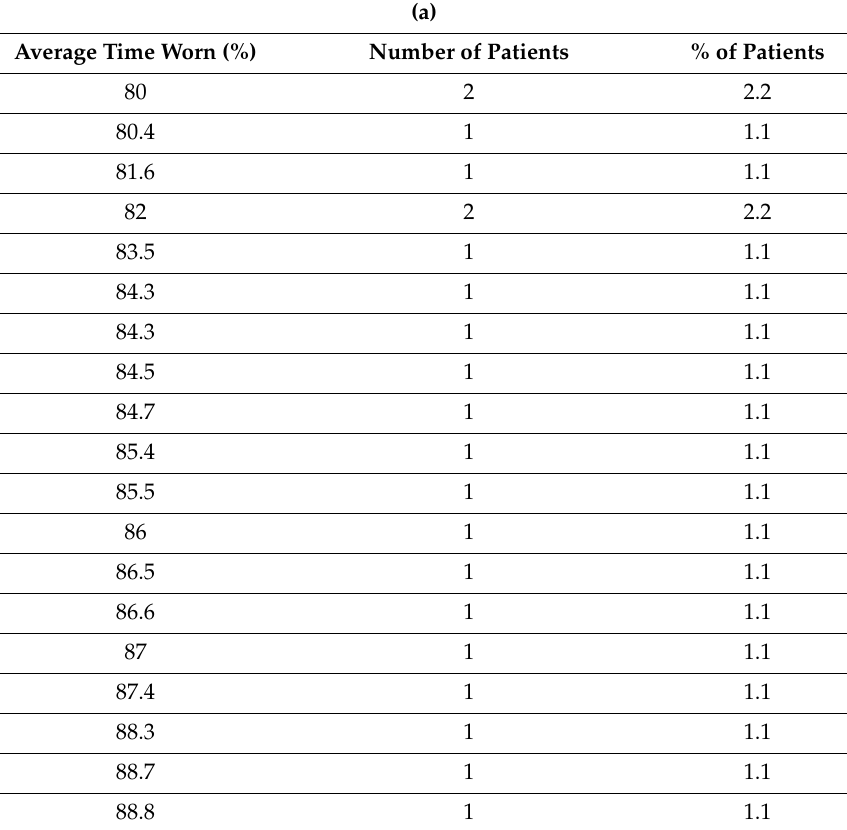
Table A2. ( a ) Patients who had a wear time ≥ 80% ( n = 63). ( b ) Di ff erences between patients with ≥ 80% wear time and < 80% wear time. Simple t-test and chi 2 tests were performed to determine a p value. (a) Average Time Worn (%) Number of